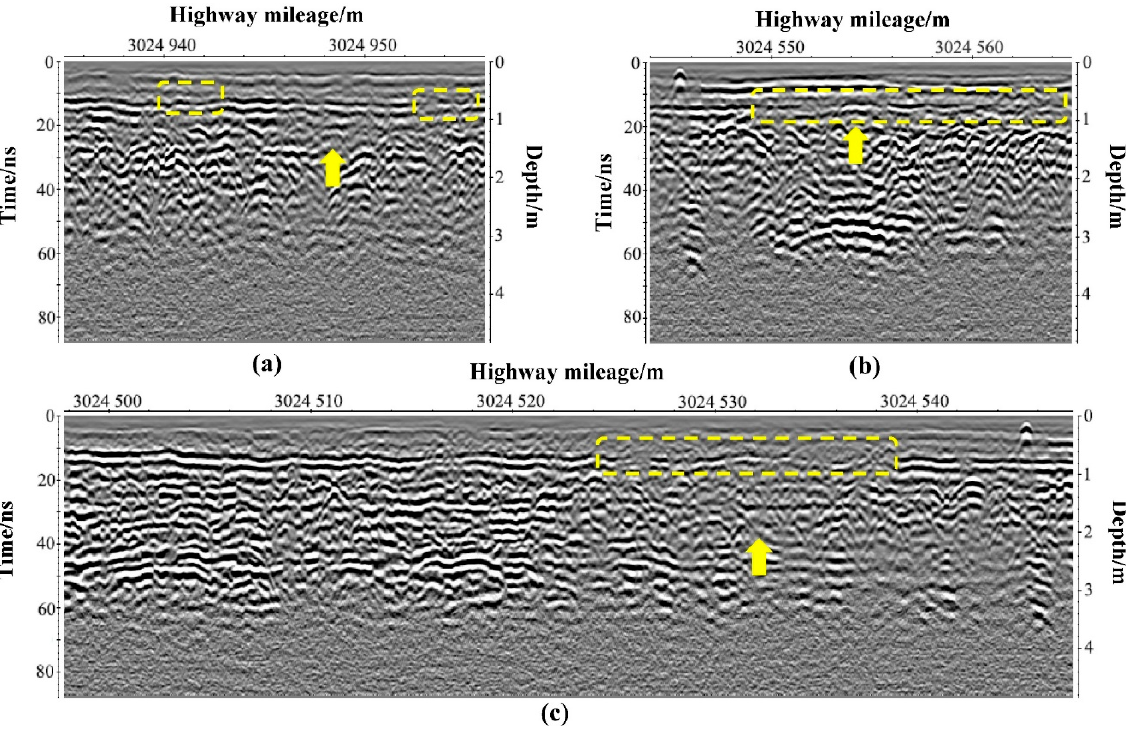
Figure 8. GPR images of the loosening of the upper sand-gravel layers: ( a ) K3024 + 935 to K3024 + 956; ( b ) K3024 + 544 to K3024 + 565; and ( c ) K3024 + 498 to K3024 + 548. The yellow dashed box shows the abnormal area of the sand-gravel layer, and the yellow arrow is used to facilitate reading.